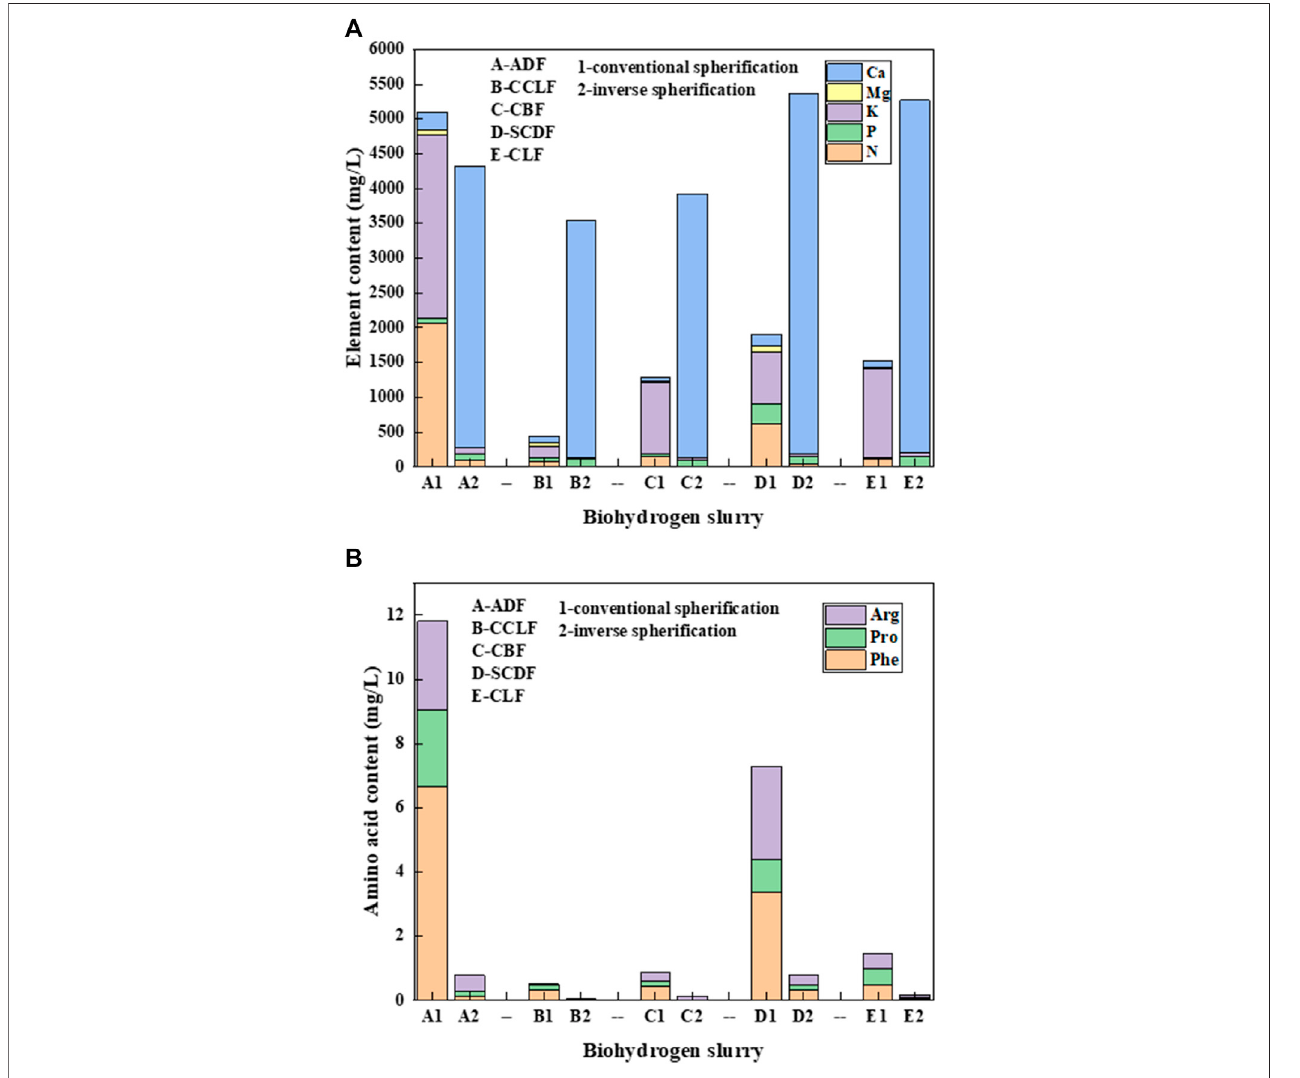
FIGURE 2 | Release effect of nutrients in fi ve kinds of biohydrogen slurry. (A) Release effect of nutrient elements. (B) Release effect of amino acids.